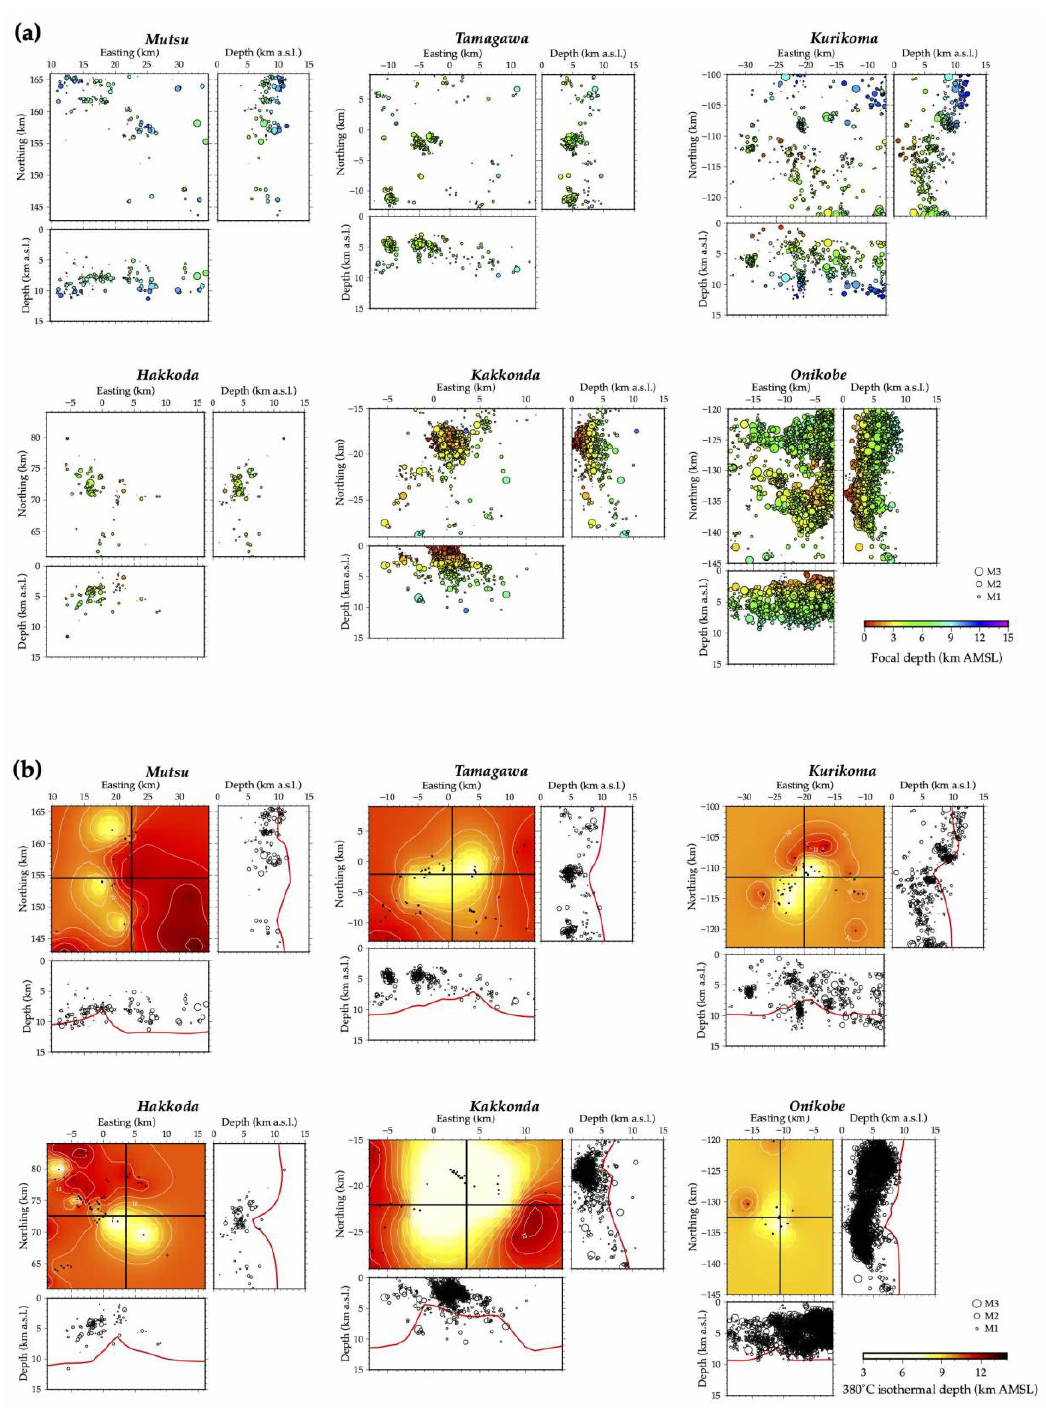
Figure 5. ( a ) Epicenter distribution maps for each study area; ( b ) maps showing depth of the 380 °C isotherm with reference to the sea level for each study area. Black dots, open circles, and red lines indicate data locations, epicenters of earthquakes, and depth of the 380 °C isotherm derived using the activity index, respectively, along the survey line (solid black line).